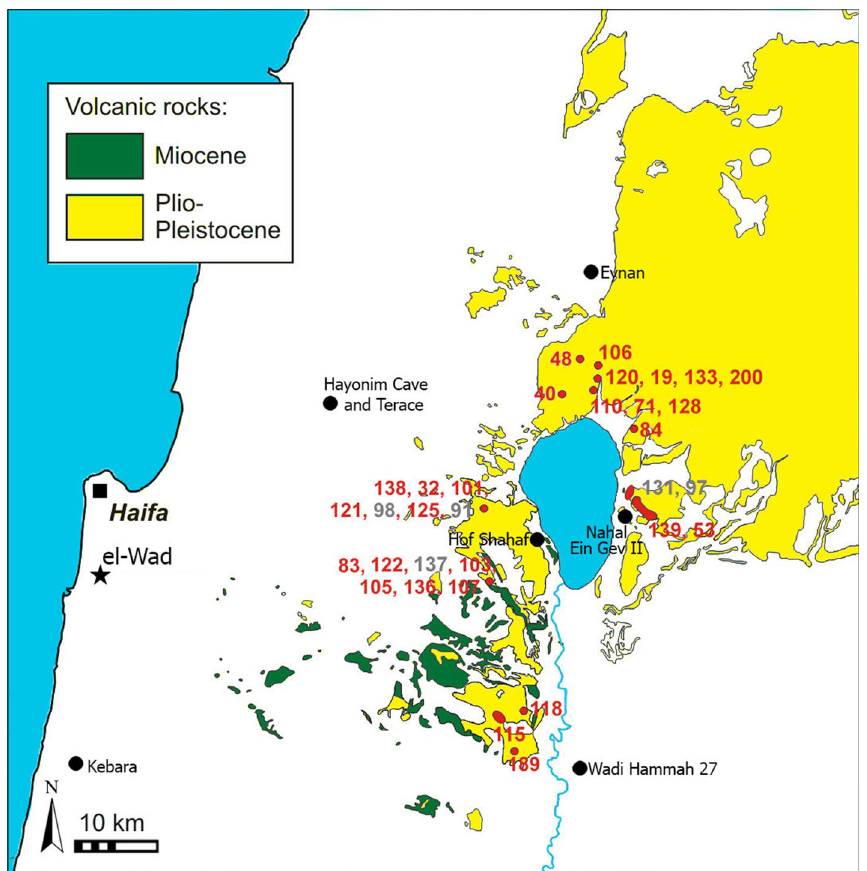
Figure 3. Provenance of the EWT pestles (see Table S1). Red dots indicate exact locations. The fields indicating the provenance of EWT 131 and 97, of EWT 139 and 53, and EWT 115 (marked in grey) define the area where the corresponding geological samples were collected. (created by T.G. in QGIS Pisa and Inkscape